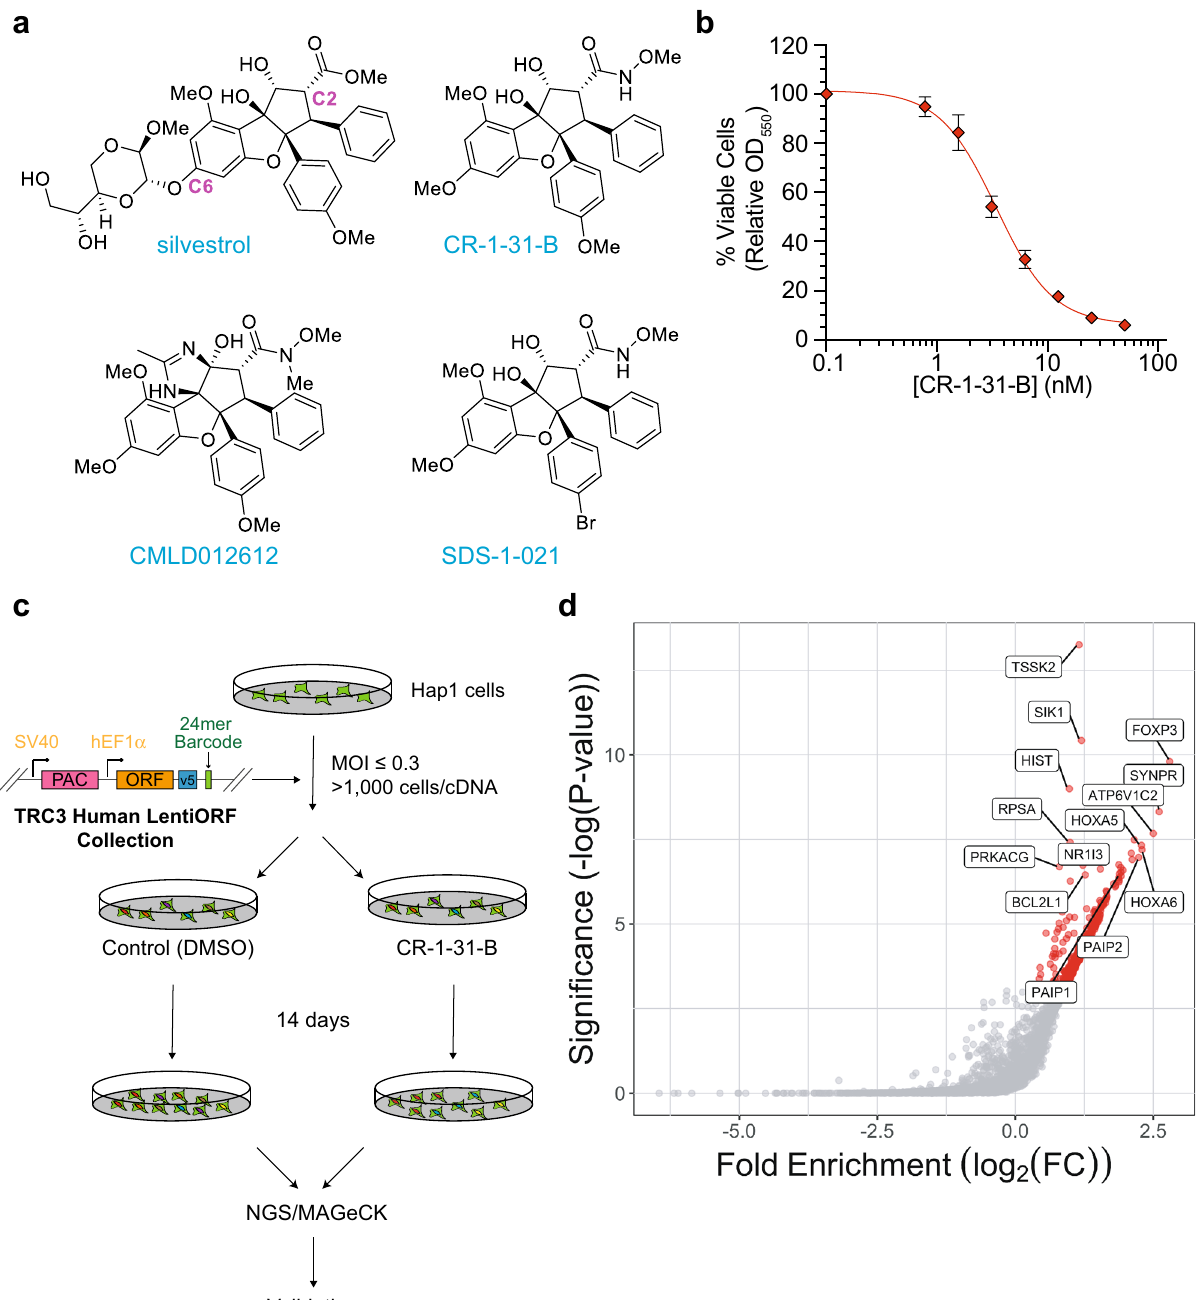
Figure 1. Forward genetic screen for modifiers of CR-1-31-B response. ( a ) Structures of the rocaglates: silvestrol, CR-1-31-B, CMLD012612, and SDS-1-021. ( b ) Titration of CR-1-31-B for 48 h onto Hap1 cells, with cell viability measured by absorbance readings at OD 550 following SRB staining. n = 3 ± SD. ( c ) Diagram visually depicting the process of cDNA overexpression, positive selection, and pooled functional genomic screening in Hap1 cells. ( d ) Scatter plot depicting the statistical significance ( P -value as calculated by MAGeCK 61 ) of the ORF enrichment plotted against the log 2 fold change in expression relative to the DMSO control. Labeled genes were selected for further